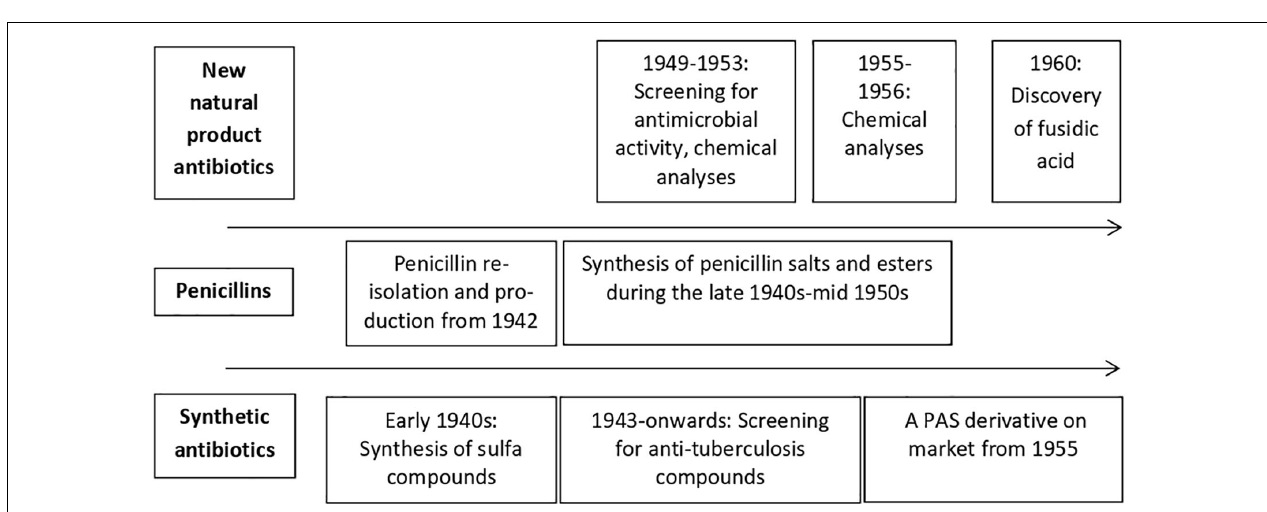
FIGURE 2 | Overall numbers of chemists at the Chemical Research Laboratory A and the Hormone Factory and specific numbers of chemists working on various categories of antibiotics at LEO from 1946 to 1959. In some cases, the workload by the individual chemist is not expressed as a whole number. This use of a non-whole number is due to their time allocation among different projects, only some of which was concerning antibiotics. New antibiotics = New natural product compounds.